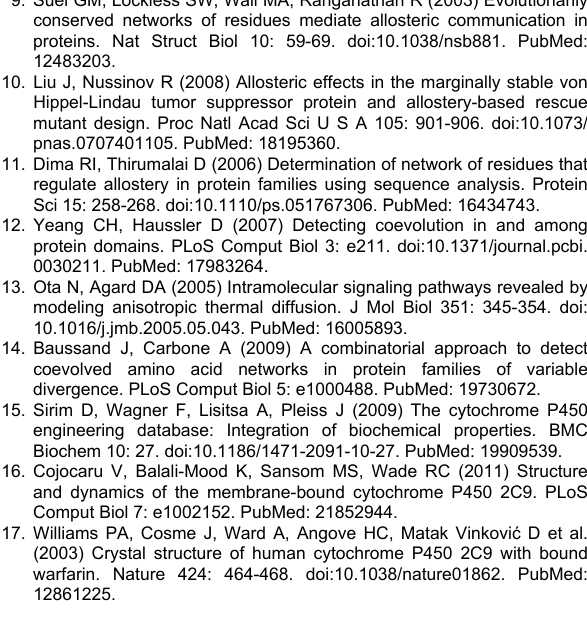
Figure S5. Comparison of root mean square fluctuations (ΔRMSFs) from anisotropic thermal diffusion simulation of naturally occurring mutants with wild-type (WT) CYP3A4: M445T ( A ), F189S ( B ), I118V ( C ), and L293P ( D ). Key residues 301-306 are highlighted by blue ovals. All residue numbers refer to the CYP3A4 sequence (PDB code 1W0E).